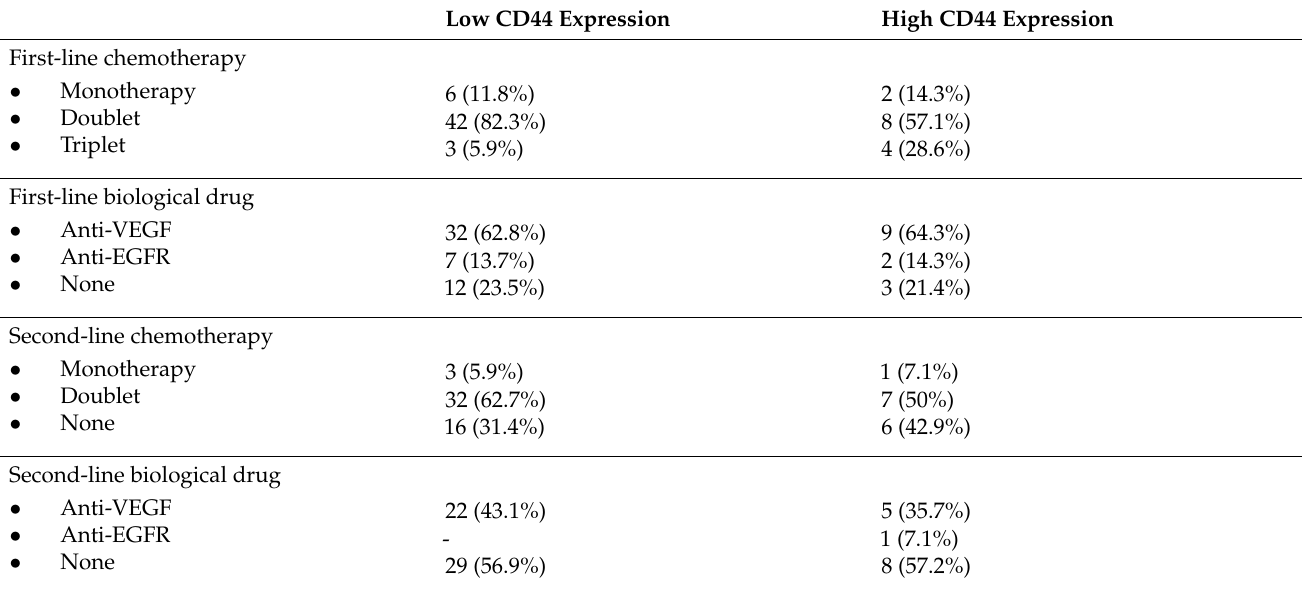
Table 2. Cont. Low CD44 Expression High CD44 Expression